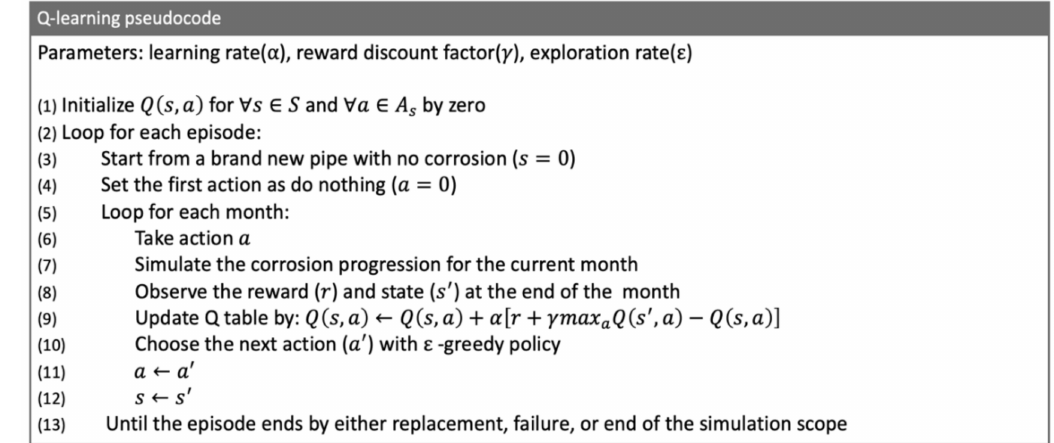
Figure 7. Pseudocode for the implemented Q-learning